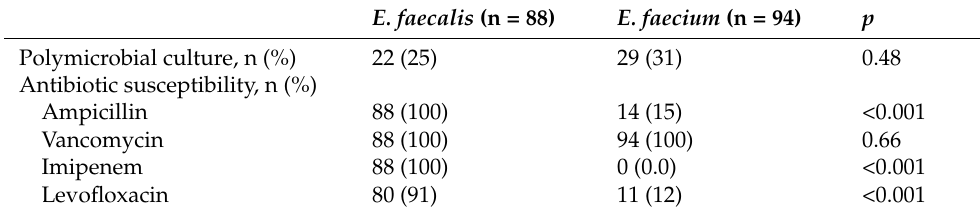
Table 2. Microbiological characteristics of enterococcal bacteremia.